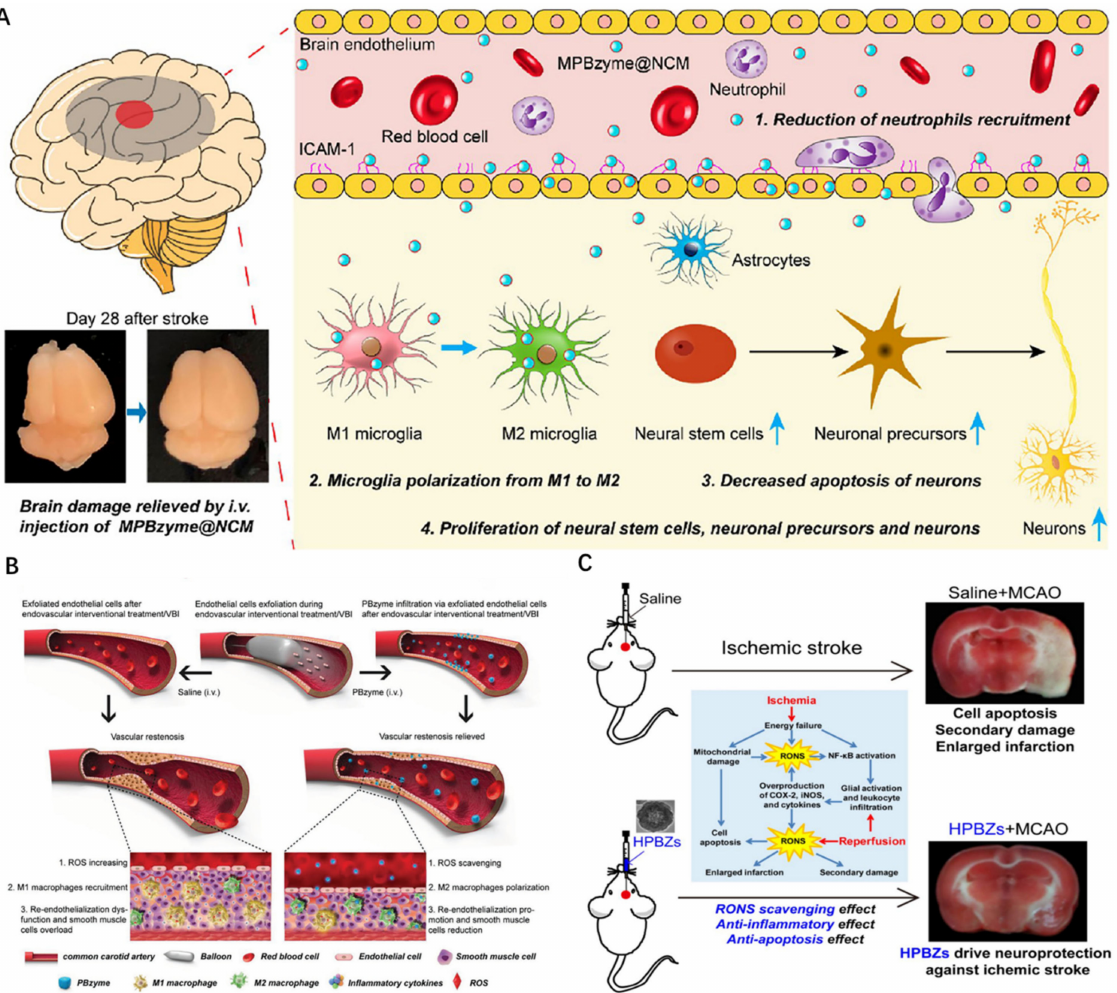
Figure 5. Schematic diagram of nano − enzymes preventing vascular restenosis. ( A ): MPBzyme@NCM detailed mechanisms for the treatment of ischemic stroke [47]. ( B ): Endothelial cell exfoliation was used to enhance the infiltration of PBzyme [26]. ( C ): Diagram of HPBzyme inhibiting apoptosis and inflammation [30]. Copyright application has been